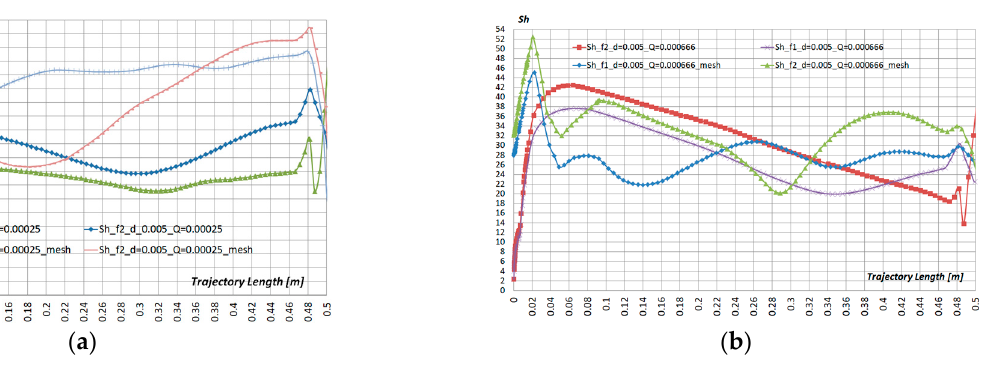
Figure 6. Mass transfer coefficient Sh , d = 500 µm: ( a ) Q = 0.00025 m 3 /s; ( b ) Q = 0.000666 m 3 /s.